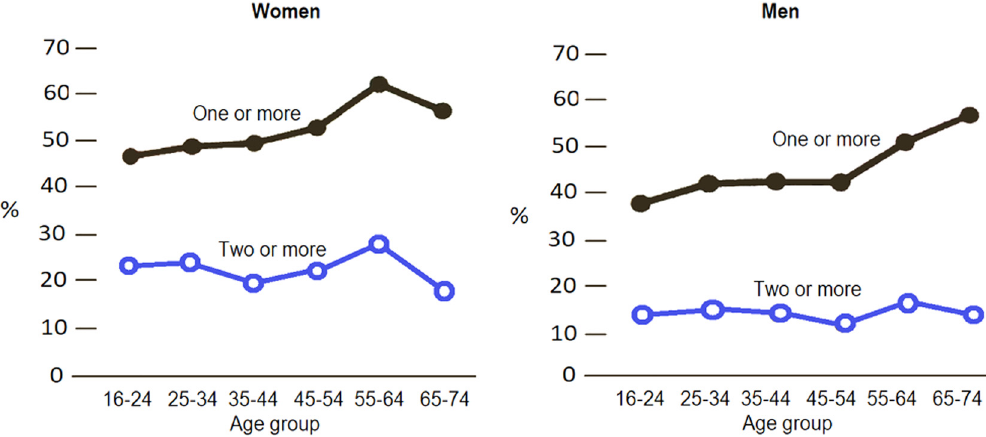
Figure 1: Proportions of sexually active men and women reporting problems ( with the permission of the author and editor ) [ 10, p. 230 ]